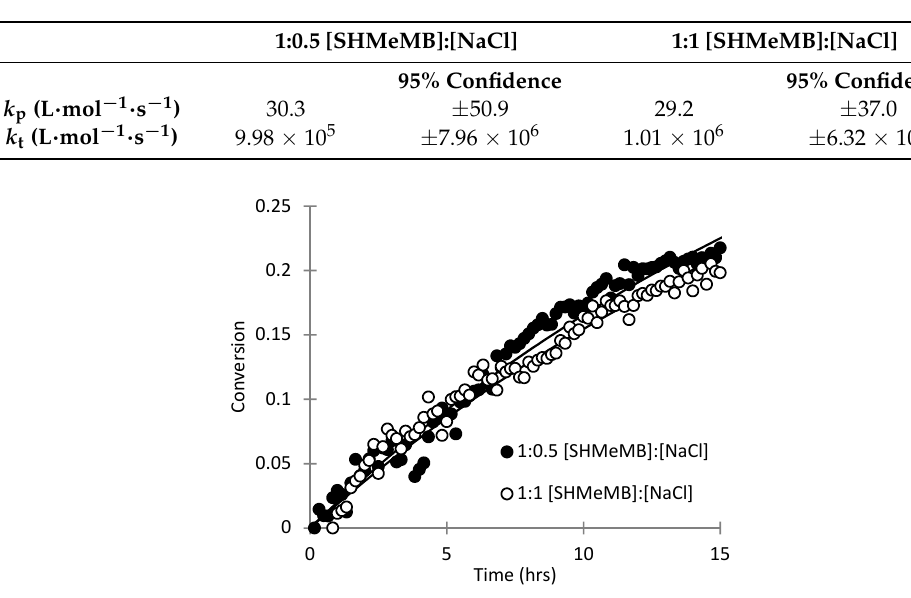
Table 4. Estimated values for k p and k t for homopolymerizations of SHMeMB with added salt at 75 °C with 1 wt % V-86 and 15 wt % monomer assuming a k dep value of 21 s − 1 . Results are shown for reactions done with 1:0.5 and 1:1 molar ratios of [SHMeMB]:[NaCl].